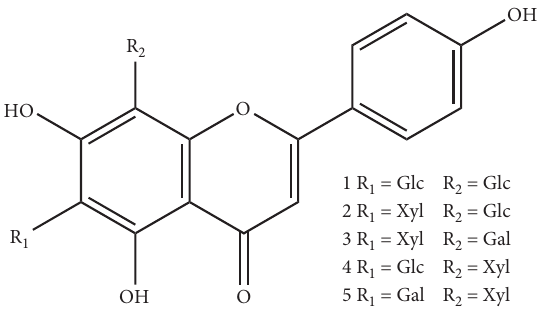
Figure 1: Chemical structures of five flavone di-C-glycosides (Glc � glucopyranoside, Xyl � xylopyranoside, and Gal �